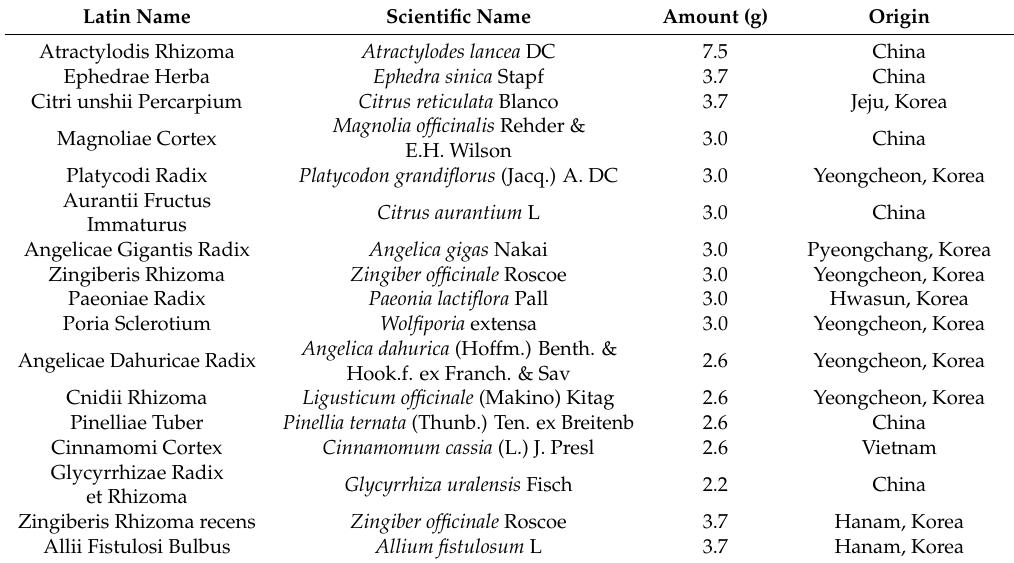
Table 1. Decoction of Ojeoksan